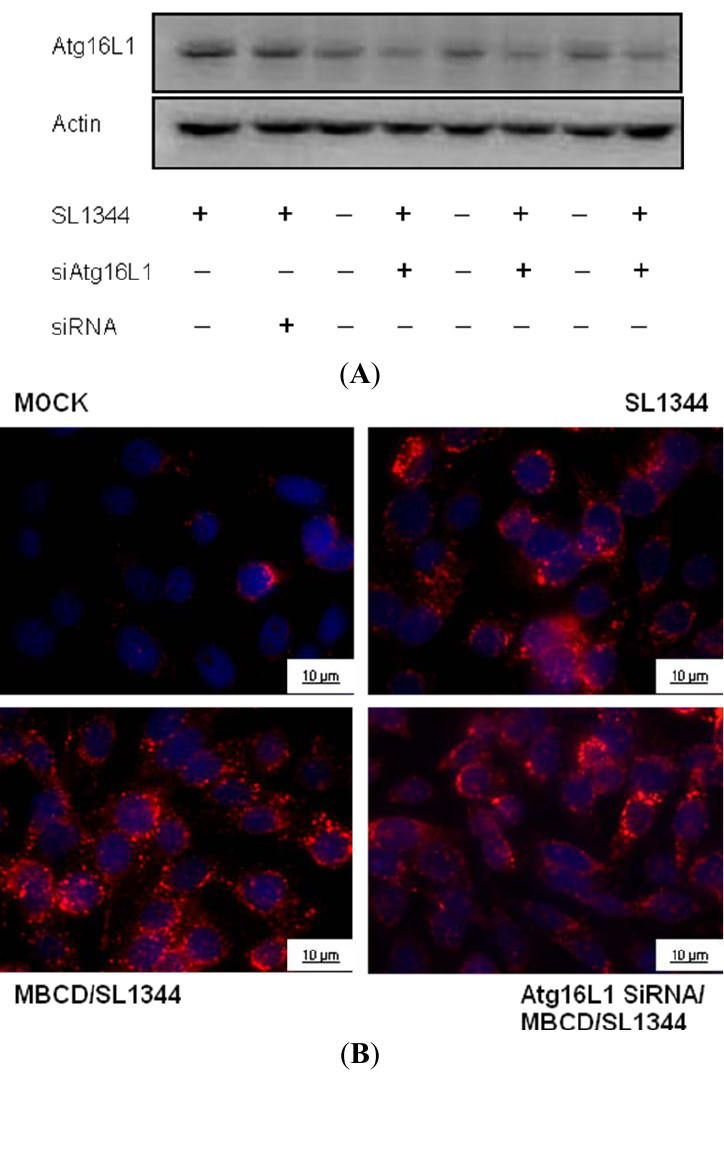
Figure 4. Involvement of Atg16L1 in enhanced Salmonella -induced autophagy by MBCD. Caco-2 cells were transfected with control siRNA or Atg16L1 siRNA (siRNA = non-target control siRNA; siAtg16L1 = siRNA to Atg16L1) for 48 h. The transfected cells were left uninfected (Con) or infected by wild-type S . typhimurium strain SL1344. ( A ) Western blots probed with antibodies against Atg16L1 and actin confirmed knockdown of Atg16L1. The transfected cells were pretreated with 4 mM MBCD for 30 min prior to wild-type S . typhimurium strain SL1344 infection for one hour. The cells were fixed, permeabilized and stained with anti-LC3 (red) and LC3 puncta formation was detected by a confocal microscope; ( B ) Representative images of LC3 punctae were depicted. Scale bar = 10 μm; and ( C ) The percentage of cells showing accumulation of LC3 punctae was reported. Data are mean ± SEM of three independent experiments. An asterisk indicates a significant difference ( p <